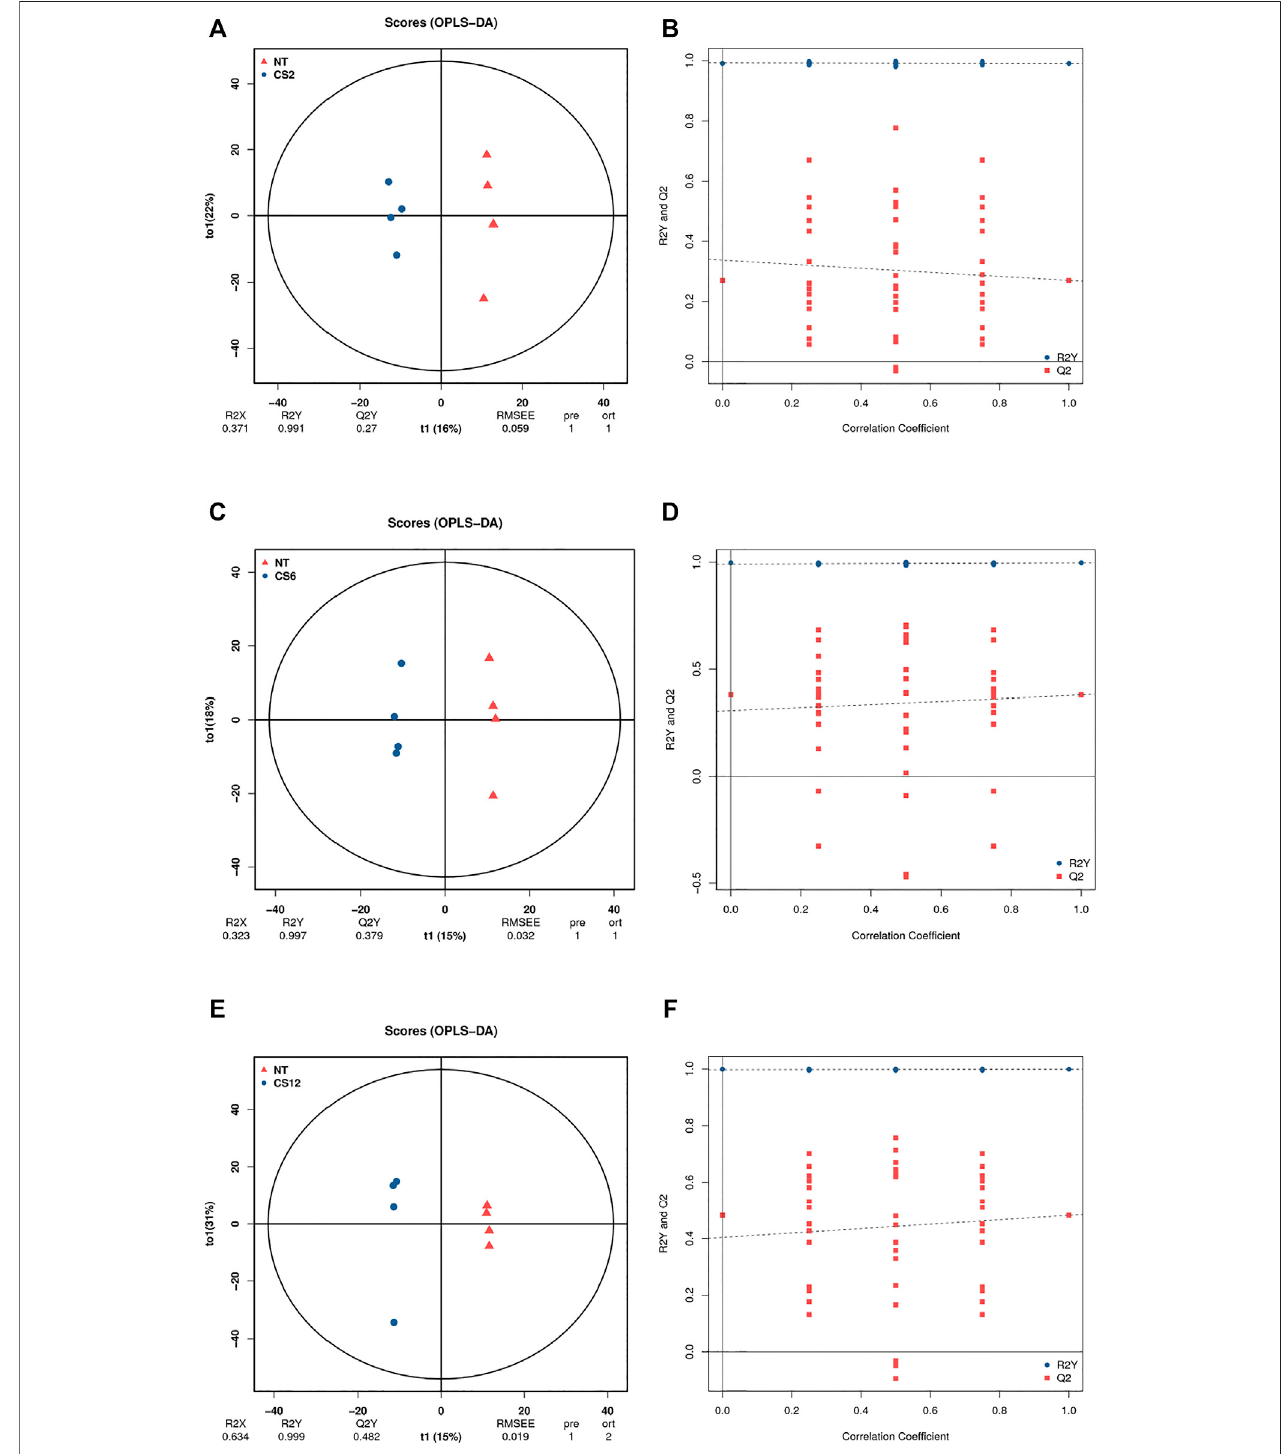
FIGURE2| OPLS-DAscoreplotdiagrams (A) ,NT vs CS2; (C) ,NT vs CS6; (E) ,NT vs CS12andpermutationtestresults (B) ,NT vs CS2; (D) ,NT vs CS6; (F) ,NT vs CS12.